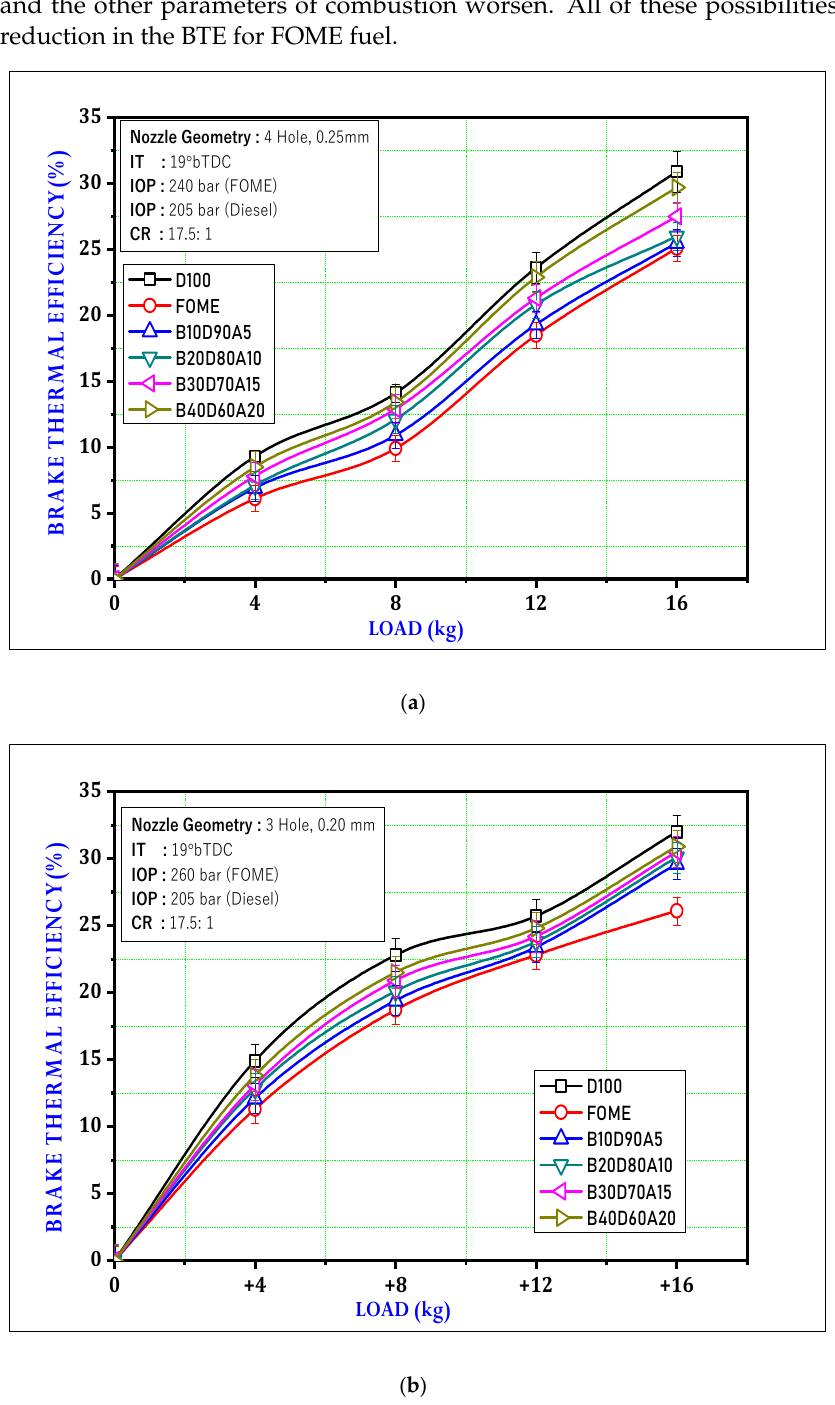
Figure 7. ( a ) BTE Variation with load for 3 holes at 240 Bar. ( b ) BTE Variation with load for 3 holes at 260 Bar.